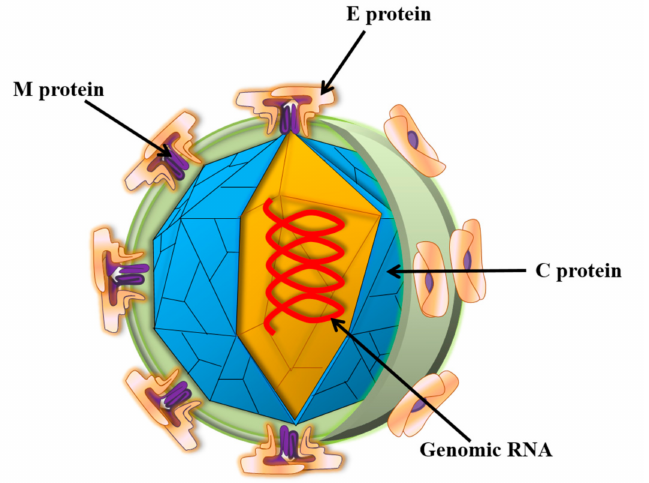
Figure 2. Schematic diagram of ZIKV structure. Zika virions are enveloped, spherical, and approxi- mately 50 nm in diameter. The surface prM/M and E proteins are symmetrically arranged on the viral surface. M: membrane; E: envelope; C: